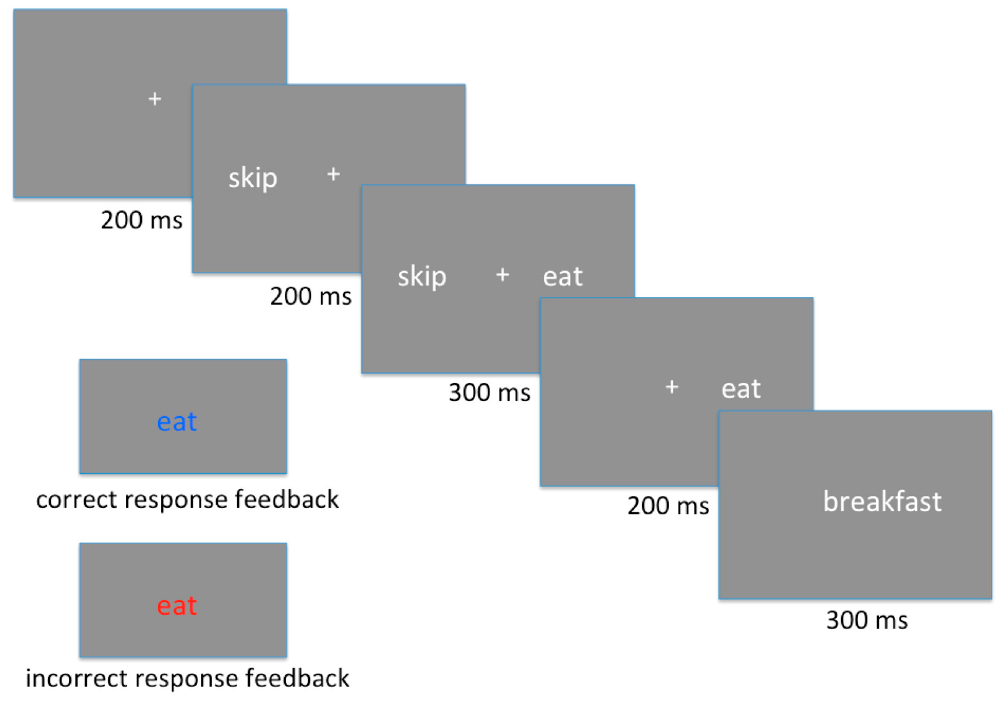
Figure 1. Sample trial of the Lexical Selection Task.